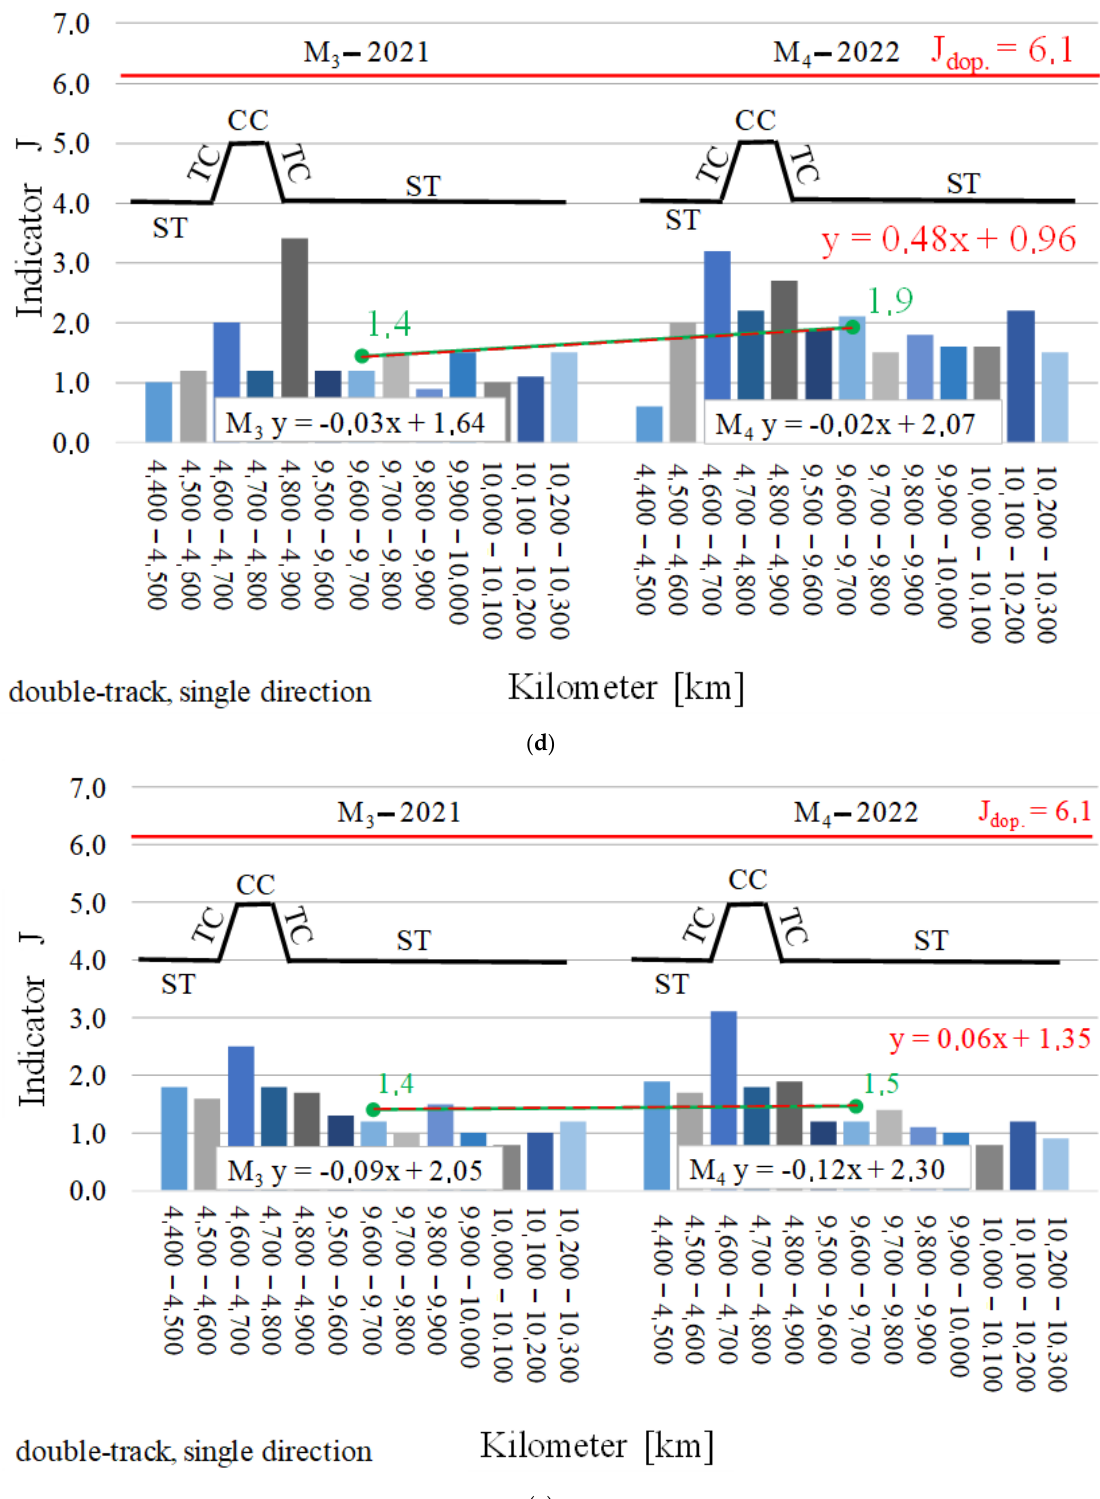
Figure 10. Confrontation of the absolute assessment (absolute estimates) J in time horizons M 1 ÷ M 4 : ( a ) Object Nos. R 143_1_1 and R 143_1_2 ; ( b ) object No. R 143_2 ; ( c ) object No. R 144_1 ; ( d ) object No. R 161_1 ; and ( e ) object No. R 161_2 . Abbreviations: transition curve— TC ; compound — C omp C ; circular — CC ; straight segment; straight linear segment— ST ; and time horizon— M i